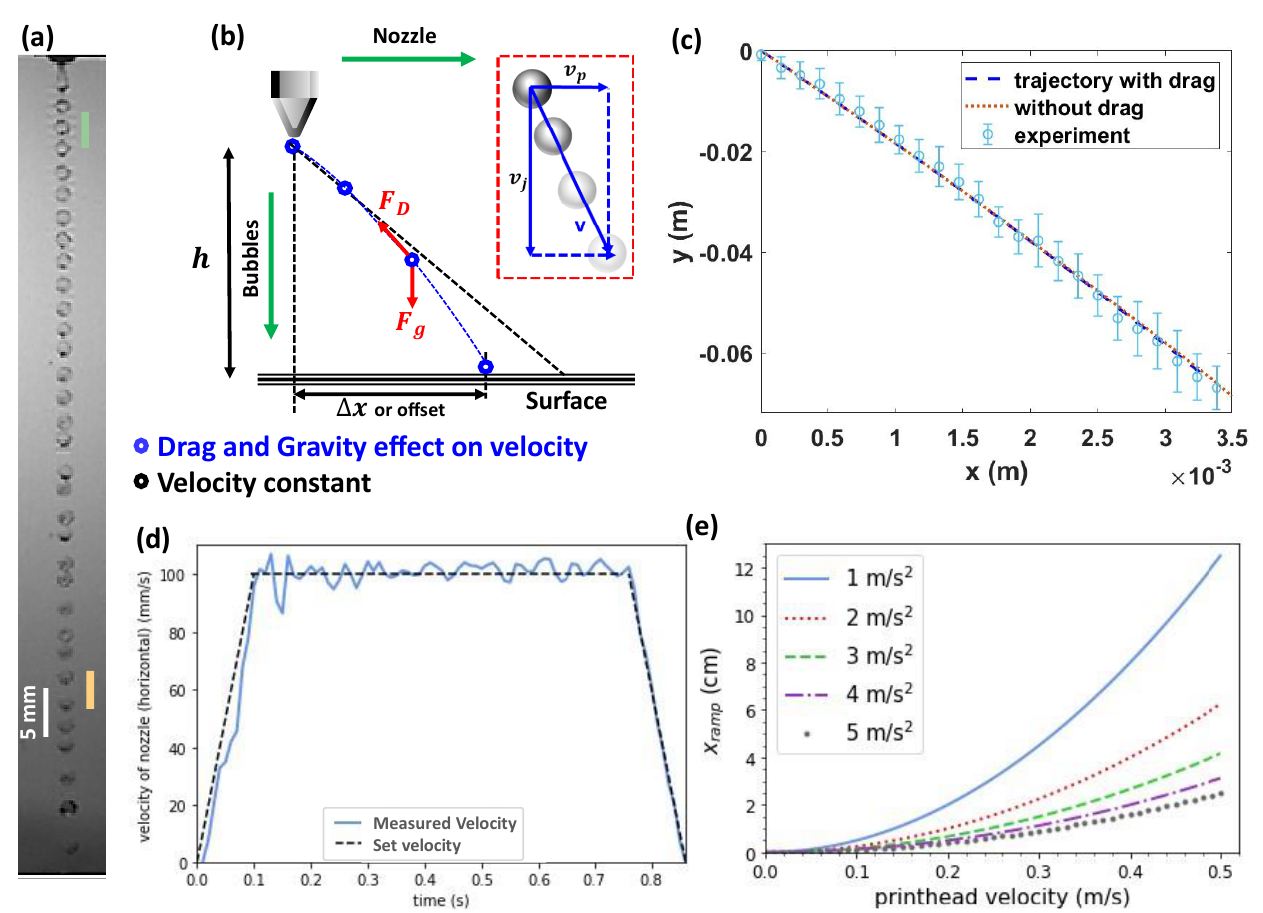
Figure 2. Characterization of the DBW process. ( a ) High speed video frame displaying stable ejection of a monodisperse bubble stream from the nozzle. The bubbles are ejected downwards with a velocity of 1.79 ± 0.11 m/s. ( b ) Example path of the bubble stream. Bubble deposition occurs at a distance ∆ x away from the ejection location. The red arrows represent the drag force and the gravity force acting on the bubbles in–flight. The black dotted line shows the trajectory of the bubbles without the influence of drag or gravity. Inset: Definition of the velocity components. ( c ) Measured trajectory of the bubbles after ejection from the nozzles. The error bars show the standard deviation of at least 16 tracked bubbles. The blue dashed and orange dotted lines indicate the calculated trajectory taking into account both drag and gravity and only gravity, respectively. The measurements are taken for Q = 12 mL/min, P = 3.5 kPa, and v p = 100 mm/s. ( d ) The printhead velocity as a function of time. The black dotted line shows the set velocity for a = 1 m/s 2 . The blue line shows the measured printhead velocity. ( e ) The calculated ramp distance traveled before attaining a constant velocity of the printhead, as a function of the velocity and acceleration.